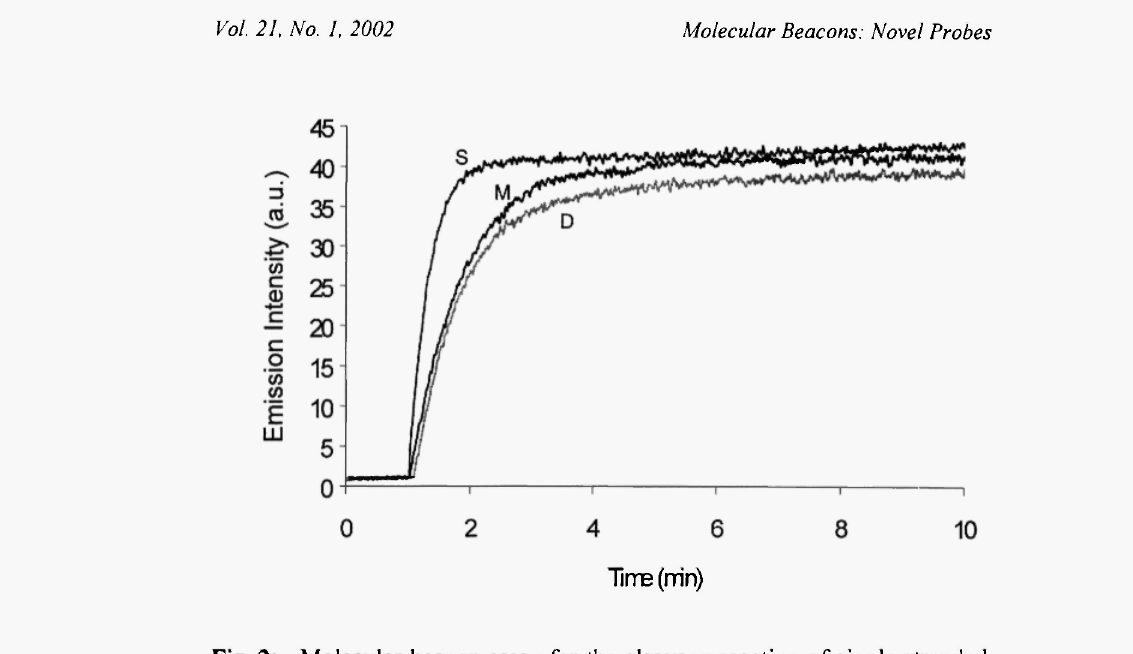
Fig. 2: Molecular beacon assay for the cleavage reaction of single-stranded DNA. All cleavage reactions catalyzed by SI (Promega, Madison, Wl) and Mung Bean (New England Biolabs, Beverly, MA) nucleases are carried out at buffer consisting of 50 mM NaAc (pH 5.0), 30mM NaCI, ImM ZnS0 4 . The cleavage buffer for DNase I (Sigma, St. Louis, MO) is similar except that ZnS0 4 is replaced by 2 mM MgCI 2 . All reactions are performed at 37°C. All excitation and emission wavelengths for time driving curves are 558 nm and 580 nm, respectively, except that 530 nm excitation is used for the emission spectrum, (a). Time driving curves of the fluorescence intensity of the molecular beacon during the digestion by several nucleases. S, Μ and D represent SI, Mung Bean and DNase I, respectively. Inset: fluorescence spectrum of the molecular beacon before (molecular beacon) and after the digestion (molecular beacon + SI), [molecular beacon]= 500 nM; [Sl]= 200 units / ml; [DNase I] = 1.6 units / ml; [Mung Bean]= 500 units / ml. Reprinted from reference 15 with